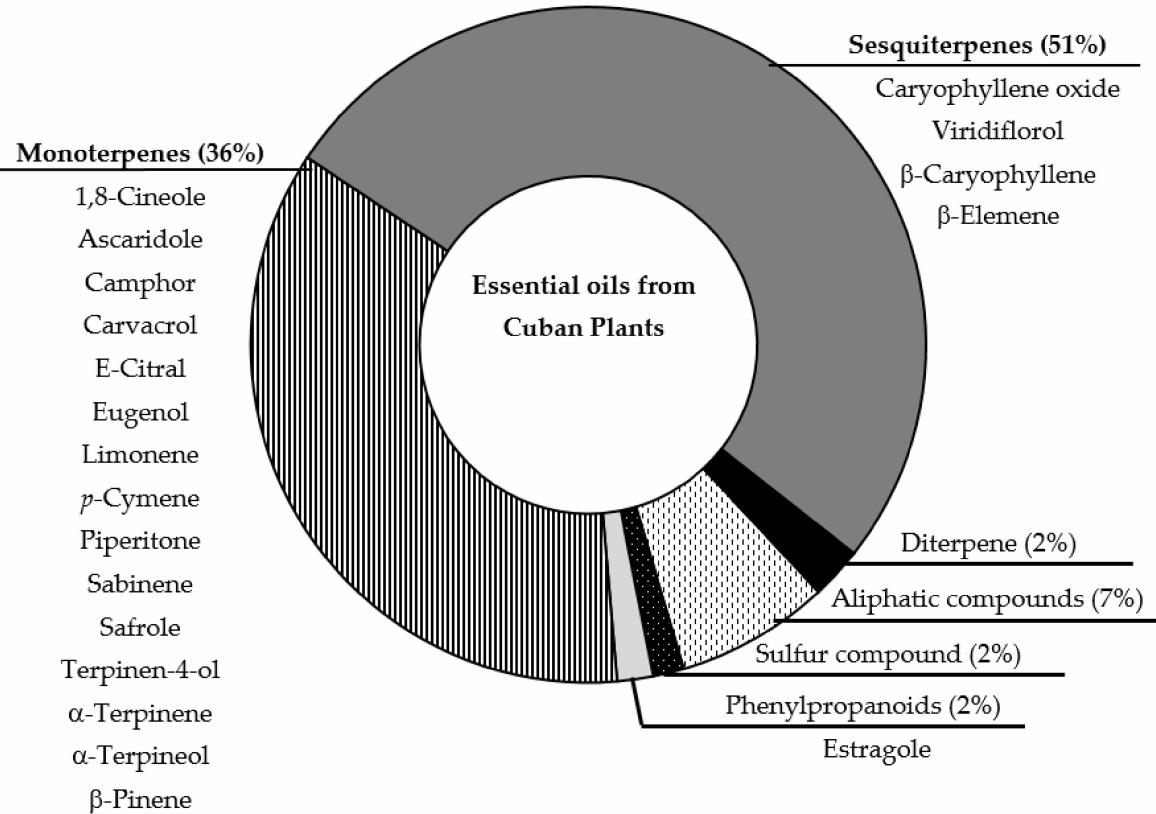
Figure 1. Schematic representation of chemical composition of analyzed EOs. Graphic represent the distribution of total components described for EOs; while list of compounds corresponds to main compounds identified in the